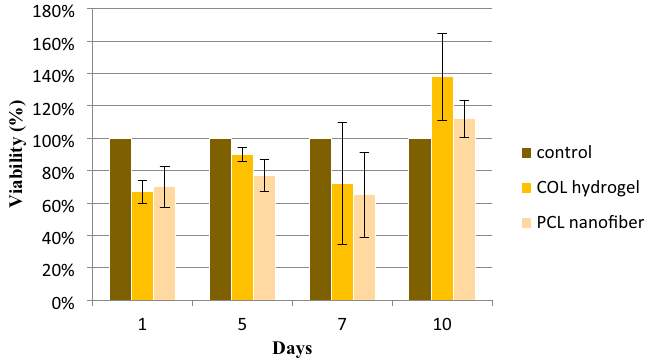
Figure 5. Viability of control, collagen hydrogel, and PCL nanofibrous mat groups on different days. Cell viability for hydrogel decreases on the 7th day while for PCL nanofibrous mat it decreases on the 5th day. There is no significant difference between the control and test groups. ( P -value > 0.5).